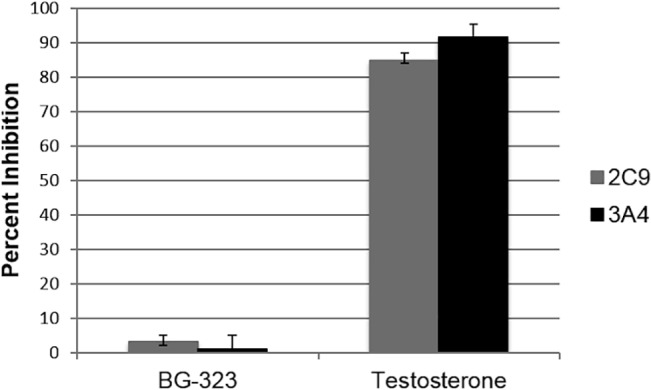
Binding to CYP P450.BG-323 and testosterone were incubated with pooled human liver microsomes. CYP P450 isoform specific substrates and NADPH were added to the reaction. The concentration for each CYP P450 specific substrate metabolite was determined using LC-MS/MS.